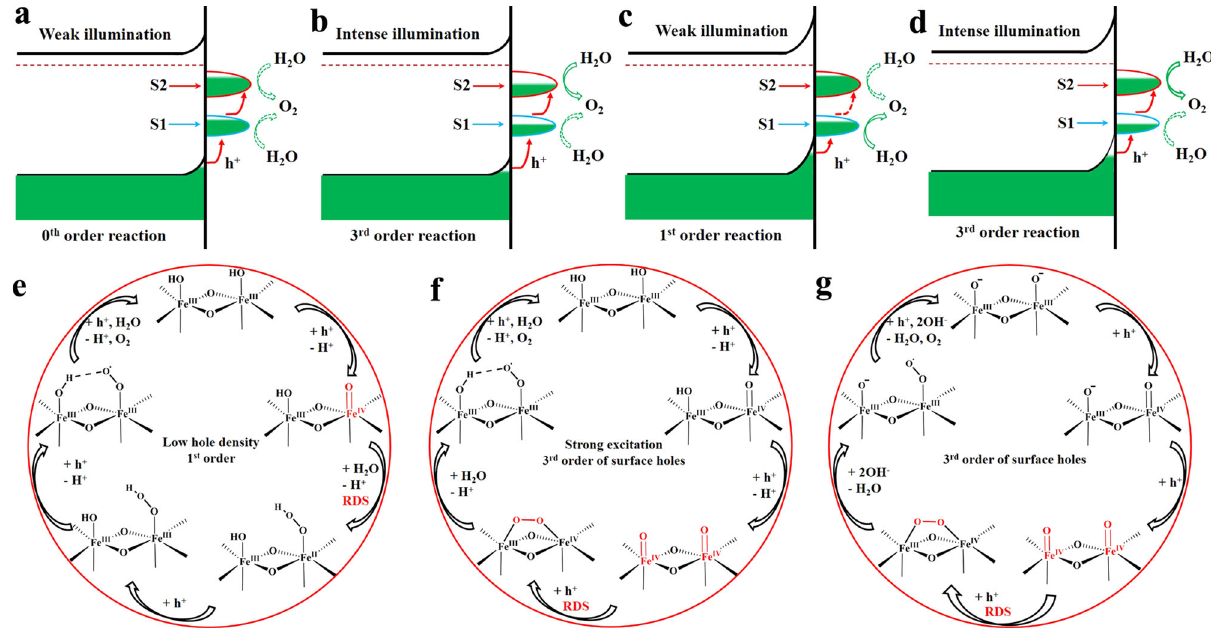
Fig. 4 Schematic illustration of the steady-state interplay of S1 and S2 and corresponding catalytic cycles. Top: the steady-state interplay of S1 and S2 at different applied potentials and illumination intensities in pH 8.0 electrolyte. a At 0.9 V vs. RHE and weak illumination (<10 mW cm − 2 ), a small fraction of photogenerated S1 is stored in the form of S2 in order to prevent recombination, while lesser amounts of accumulated S2 are unable to initiate OER effectively. This results in zero-order kinetics with respect to surface holes. b At 0.9 V vs. RHE and intense illumination ( ≥ 10 mW cm − 2 ), S2 has achieved suf fi cient surface occupancy, so that the subsequent hole injection will give rise to OER. Third-order reaction kinetics of surface holes is observed. c At 1.3 V vs. RHE and weak illumination (<10 mWcm − 2 ), photogenerated S1 is able to directly initiate OER as the recombination process is signi fi cantly retarded. This gives rise to fi rst-order reaction kinetics with respect to surface holes. d At 1.3 V vs. RHE and intense illumination ( ≥ 10 mW cm − 2 ), the accumulation of S1 promotes the fast formation of S2 at lower energy, so that OER is now proceeding via a low energy barrier third-order pathway (dashed arrows, very slow processes; solid arrows, fast processes). Bottom: Proposed catalytic cycles at pH 8 and 1.3 V vs. RHE e under weak illumination (<10 mW cm − 2 , low surface hole density), where the nucleophilic addition of water to the Fe IV = O site represents the RDS, f under intense illumination (>10 mWcm − 2 , high surface hole density), where the third hole oxidation of the edge site Fe IV ( = O) – O – Fe IV ( = O) becomes the RDS. g However, at pH 13, the RDS is still associated with the third hole oxidation of the edge site Fe IV ( = O) – O – Fe IV ( = O) across the applied illumination intensity range (5 – 100 mW cm − 2